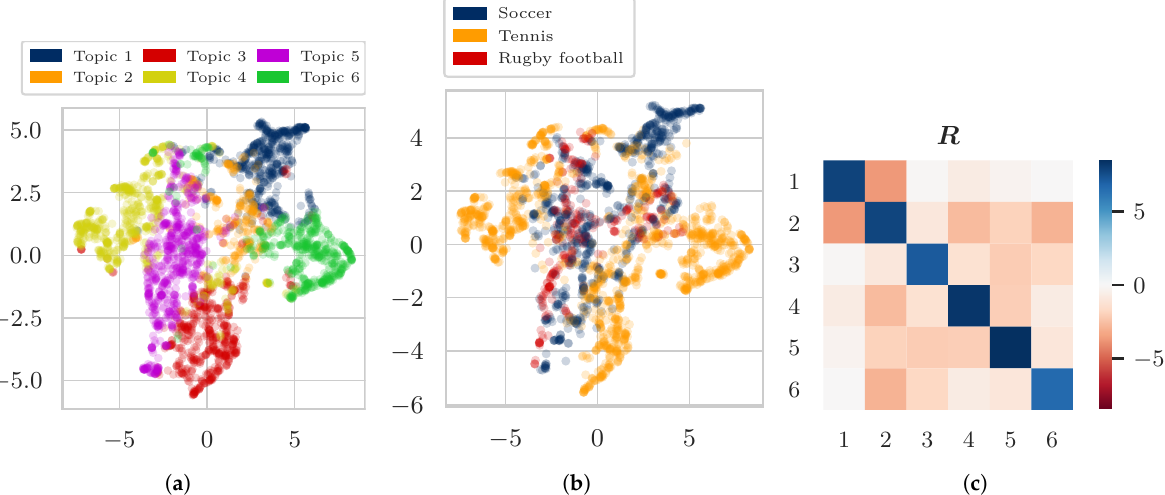
Figure A2. ( a ) 2-dimensional representation of word embeddings A (cid:48) colored by topic assignment. ( b ) 2-dimensional representation of word embeddings A (cid:48) colored by original Wikipedia article assignment (words that occur in more than one article are excluded). ( c ) Colored heatmap of affinity matrix R